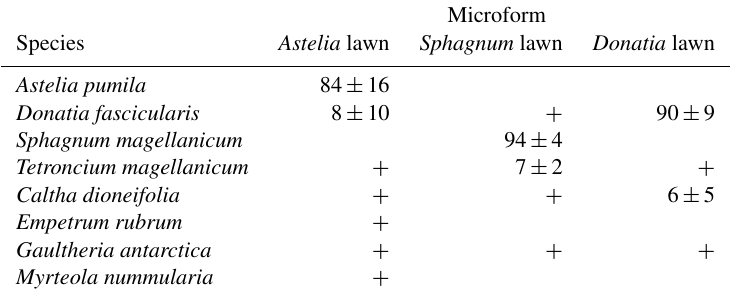
Table 1. Characteristic plant species of dominant microforms in a Patagonian cushion bog. Species composition was determined during the second measurement campaign within collars where closed chamber measurements were conducted. Mean cover (%) and its standard deviation of characteristic were given and plant species with a mean cover <5% were listed with +